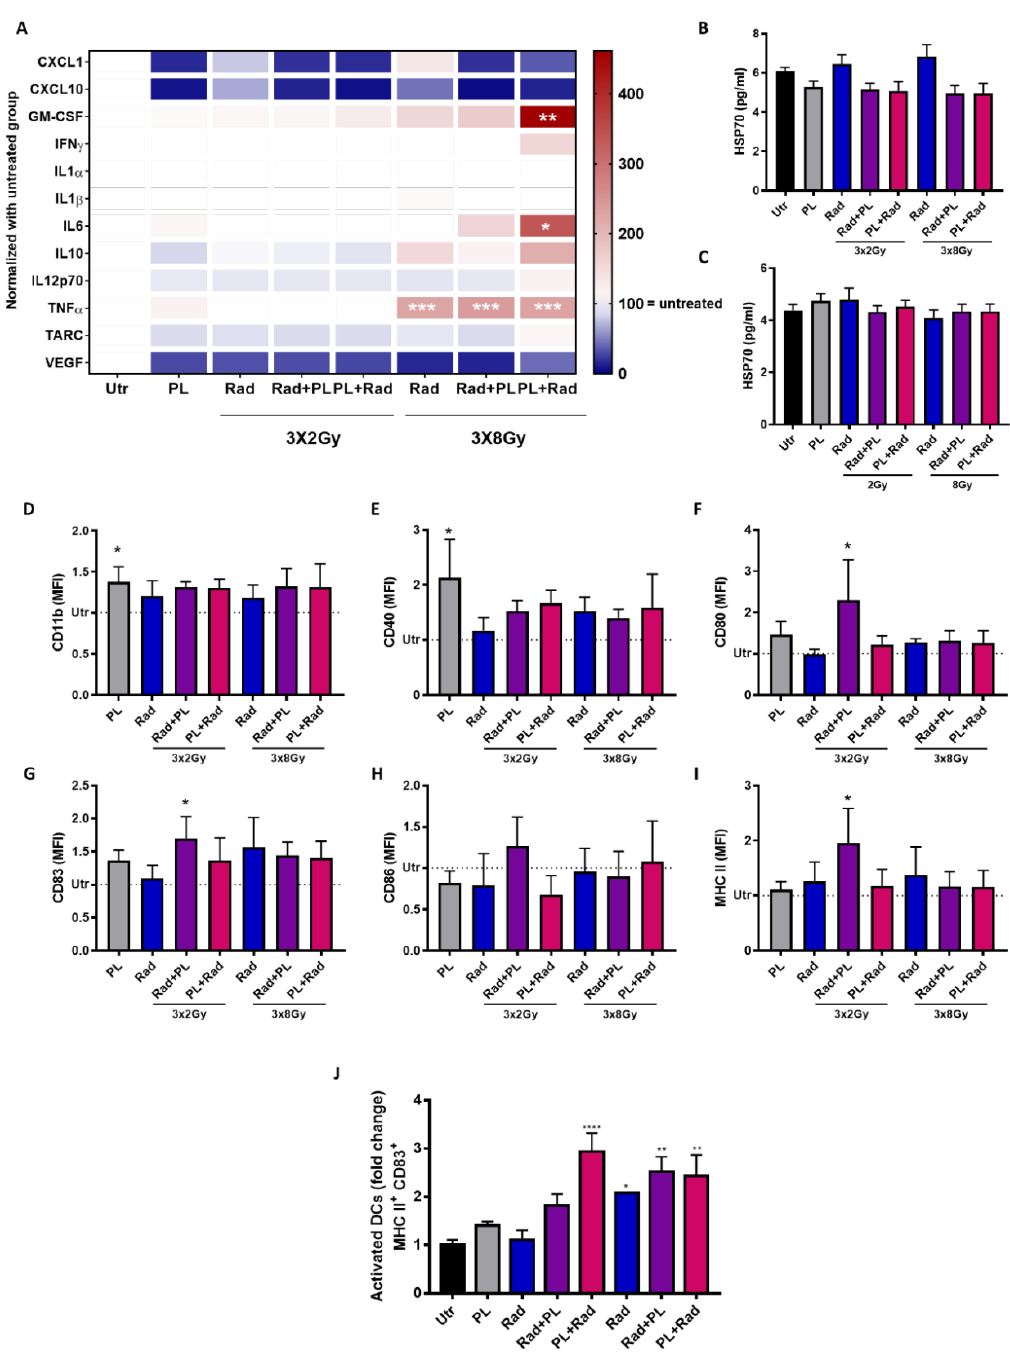
Figure 4. Secretory profile of B16F10 melanoma cells and immunological consequences in dendritic cells. ( A – C ) Multiplex cytokine analysis ( A ) and HSP70 ELISA of supernatants of murine B16F10 cells receiving plasma (10 s at 0 h), fractionated radiotherapy (at 0, 24, and 48 h), or both, collected at 24 h after the last radiation dose ( B ), or mono or combination single radiotherapy with plasma ( C ); ( D – J ) JAWS murine dendritic cells cultured for 96 h with supernatants of B16F10 cells, and multicolor flow cytometry mean fluorescent intensity (MFI) analysis of activation markers CD11b ( D ), CD40 ( E ), CD80 ( F ), CD83 ( G ), CD86 ( H ), and MHC class II on viable cells ( I ) as well as percentage of MHC class II and CD83 double positive cells ( J ). Data are representative and mean + SE of three experiments. Statistical analysis was performed by one-way ANOVA. Gy = gray, Utr = untreated, PL = plasma, Rad = radiotherapy; * = p < 0.05, ** = p < 0.01, *** = p < 0.001, **** = p < 0.0001.